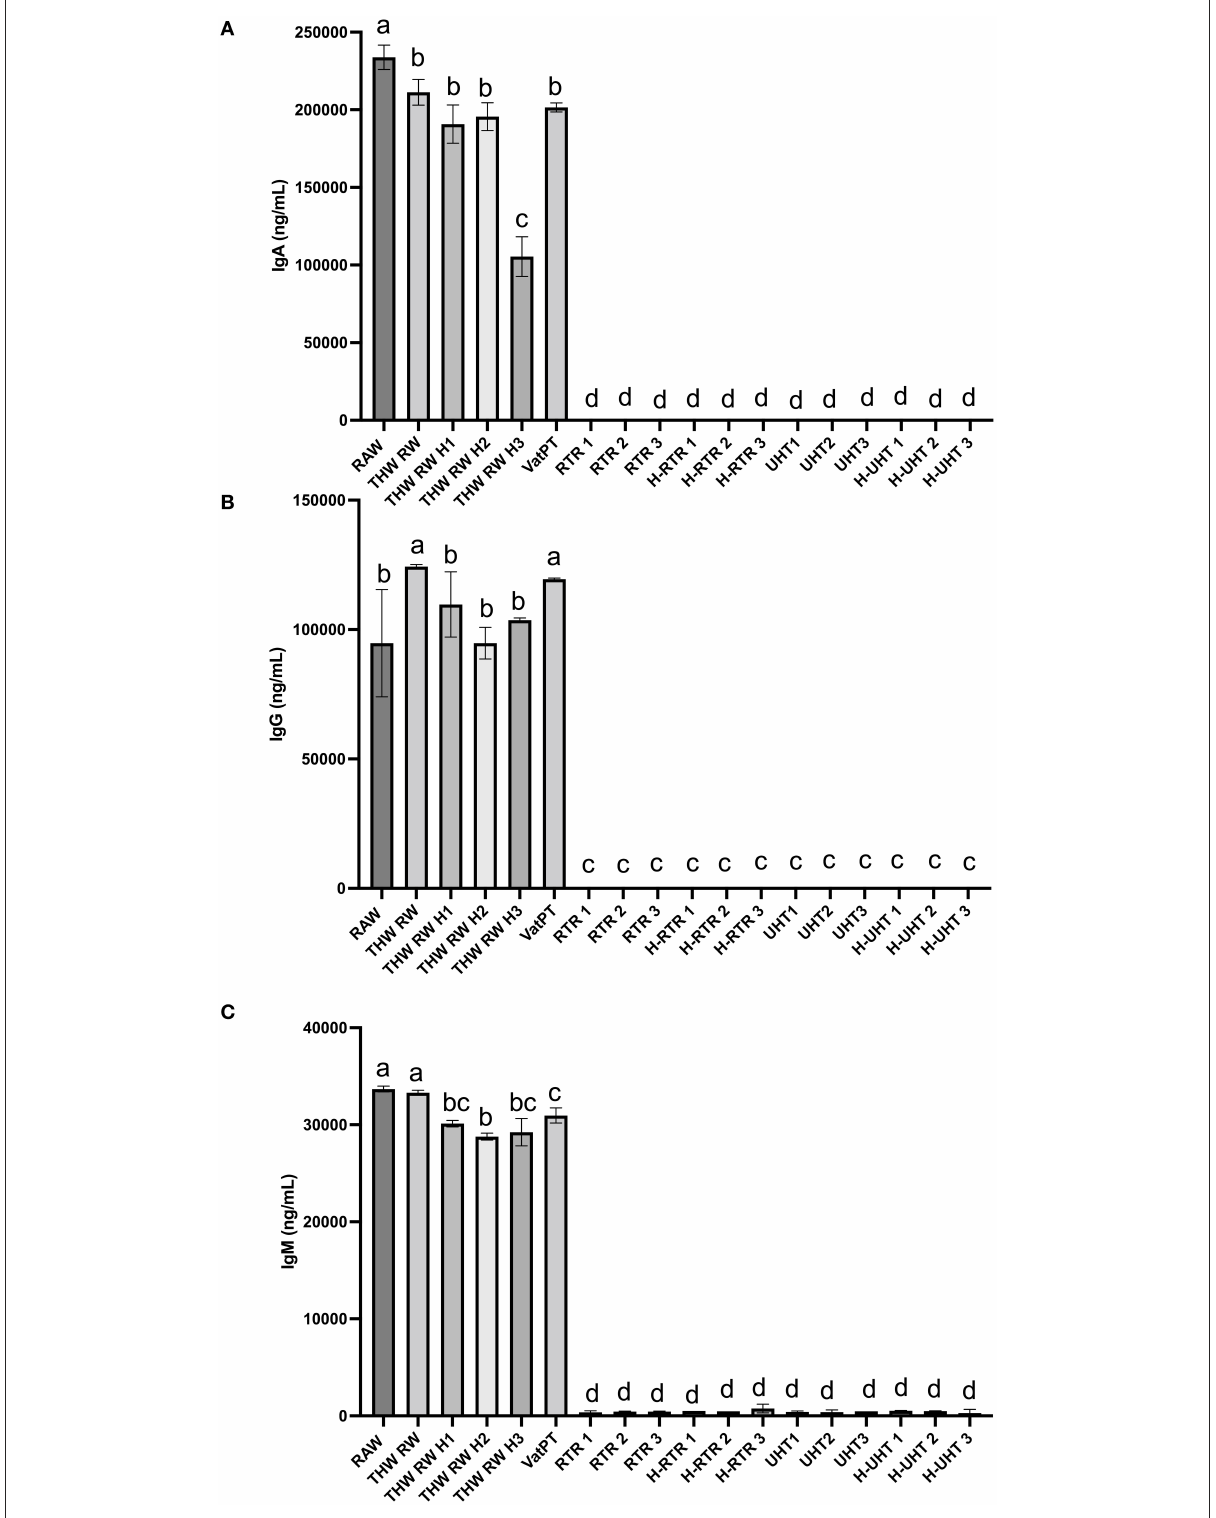
FIGURE2 Concentrations of (A) IgA, (B) IgG, and (C) IgM in the donor human milk samples: raw milk (Raw), thawed raw milk (Thaw Raw), thawed and homogenized raw milk (Thaw Raw H1, Thaw Raw H2, and Thaw Raw H3), vat-pasteurized milk (Vat-PT), retort treated milk (RTR 1, 2, and 3), homogenized and retort treated milk (H-RTR 1, 2, and 3), ultra-high-temperature treated milk (UHT 1, 2, and 3), and homogenized and ultra-high-temperature treated milk (H-UHT 1, 2, and 3). One-way analysis of variance (ANOVA) with post hoc Tukey’s tests were used to identify significant ( p < 0.05) differences between treatments, denoted by